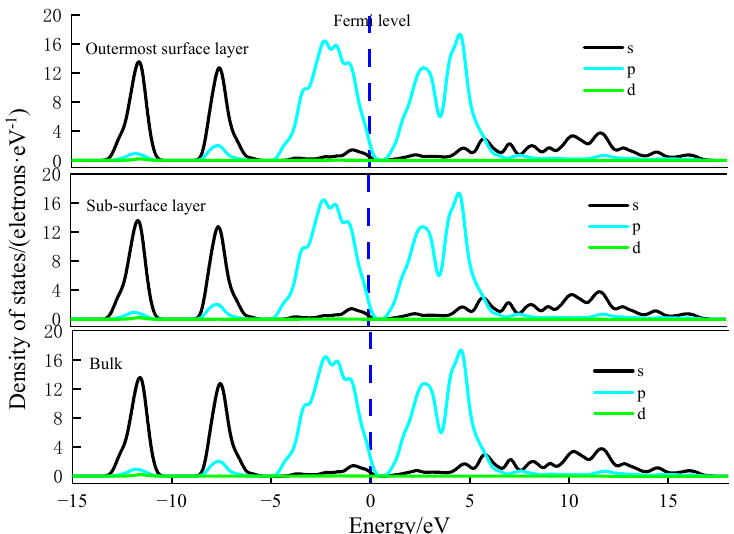
Figure 11. The density state of Pb atoms of the outermost surface layer, sub-surface layer, and bulk on (100) surface of the galena.